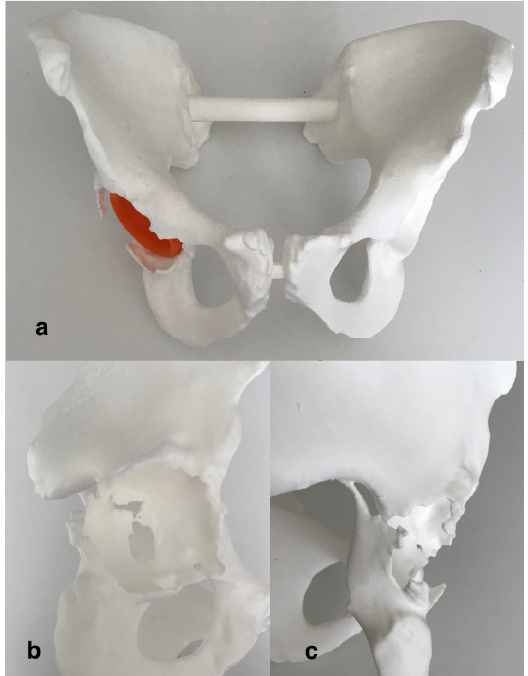
Figure 4. ( a ) 3D printed, real-size, plastic model of the entire pelvis. ( b,c ) Particular of the fracture